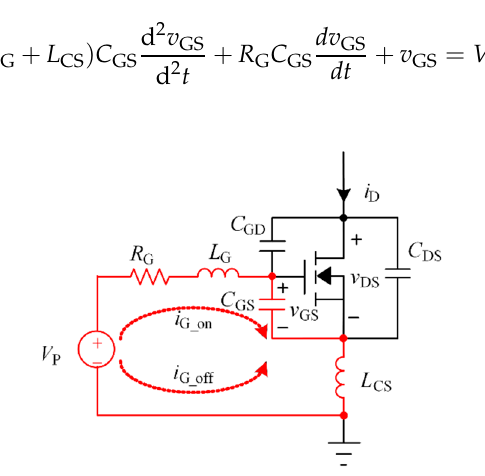
Figure. 8 Gate drive considering parasitic parameters.